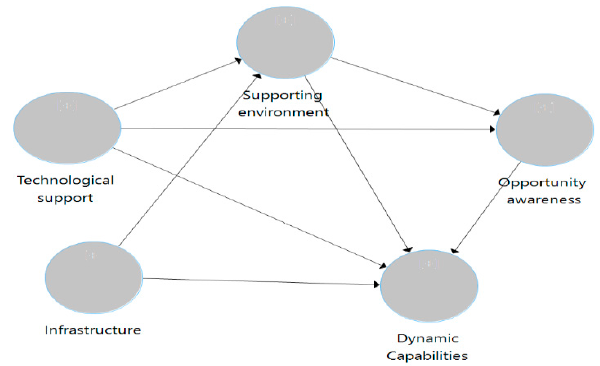
Figure 1. Conceptual framework (Source: authors’ formulation).